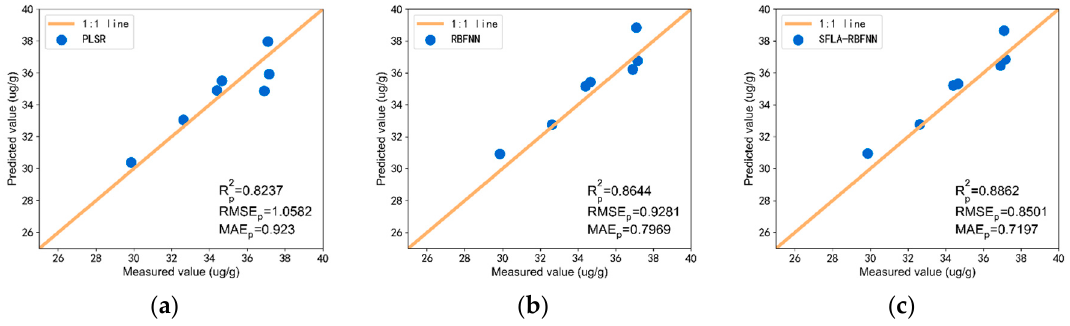
Figure 9. sCARS-SPA estimated results in Honghu: ( a ) PLSR estimated results; ( b ) RBFNN estimated results; ( c ) SFLA-RBFNN estimated results.